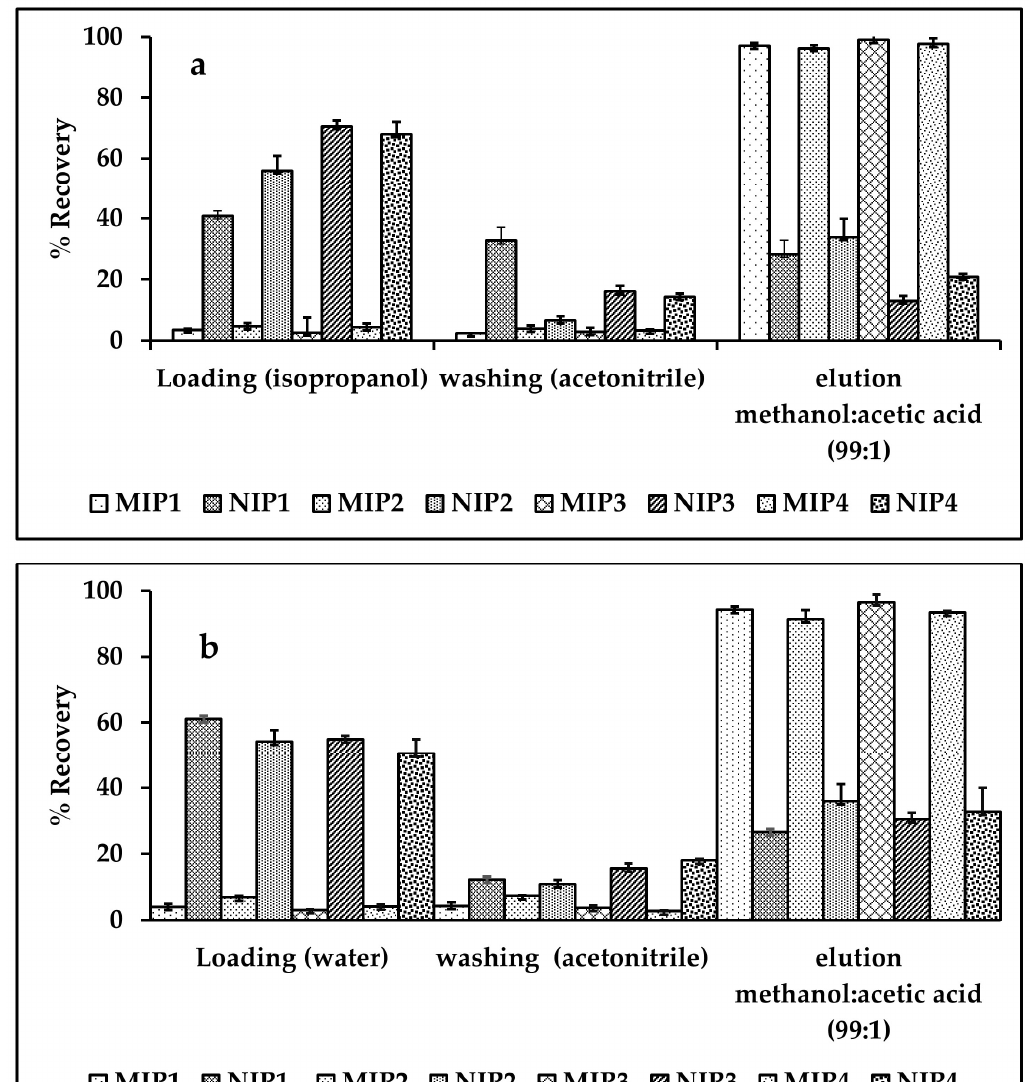
Figure 5. Optimization of MIP and NIP: ( a ) loading with isopropanol, ( b ) loading with water.